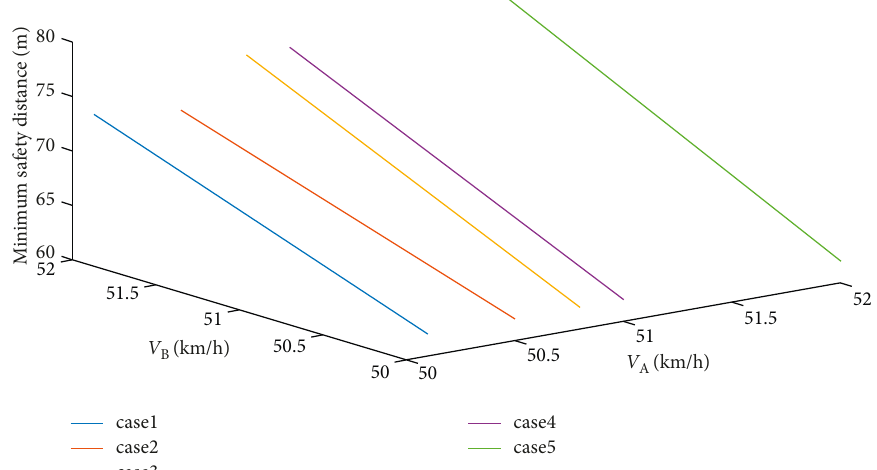
Figure 7: Minimum safety distance under uniform deceleration state of the front vehicle ( V